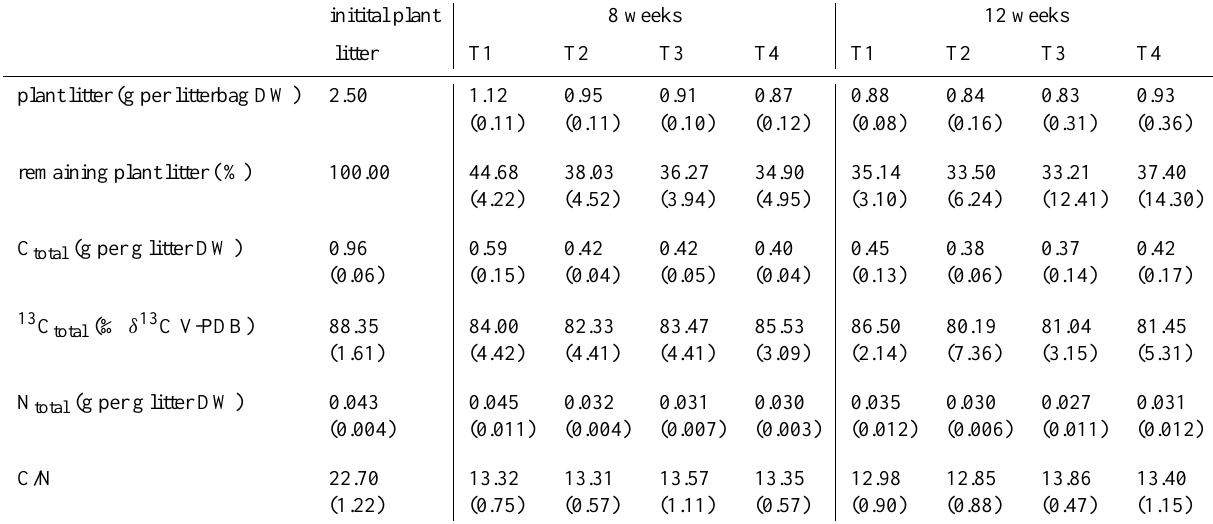
Table 2. Litter mass loss and selected plant litter parameters obtained from litter bags during the incubation period along the Damma forefield (means of n = 5 ± standard deviation).